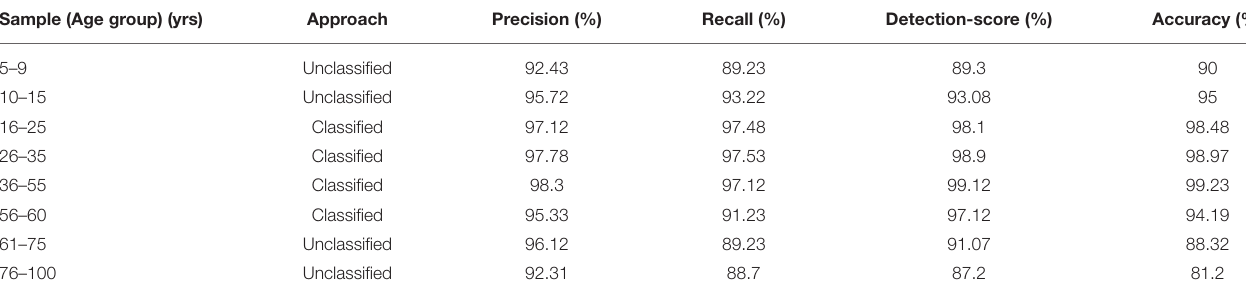
TABLE 2 | Performance matrix for speech signal in mental distress